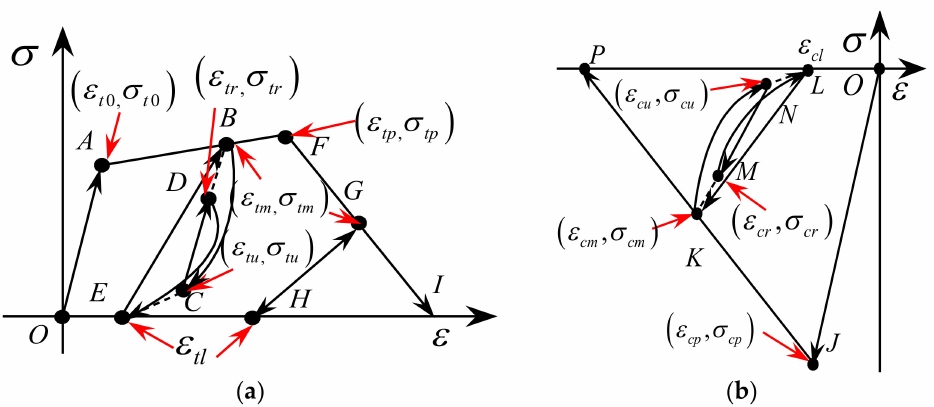
Figure 4. Unloading and reloading rules of the ECC model ( a ) Tension region; ( b ) Compression region